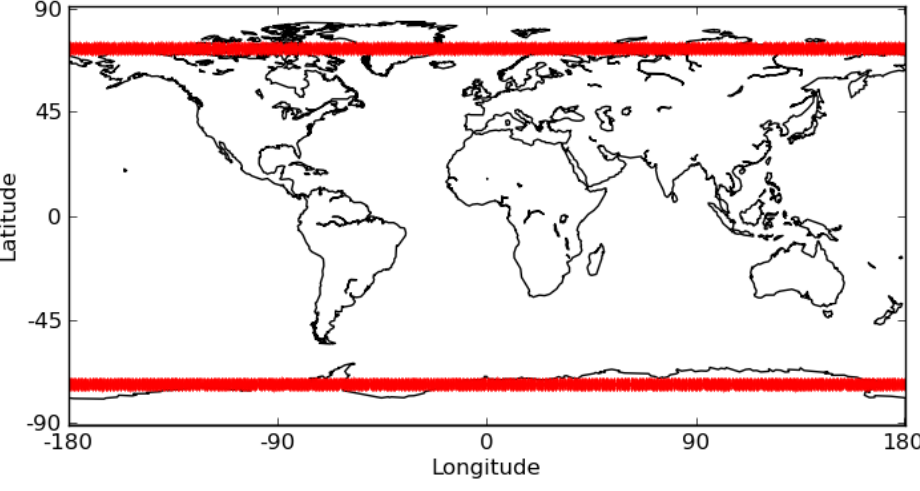
Figure 3. Distribution of realized SNO match-ups within 10 min for ENVISAT AATSR/MERIS and AQUA MODIS in the period 2007–2009. Notice that for MERIS and for AATSR visible channels only half of the match-ups are useful ( i.e. , available during daytime